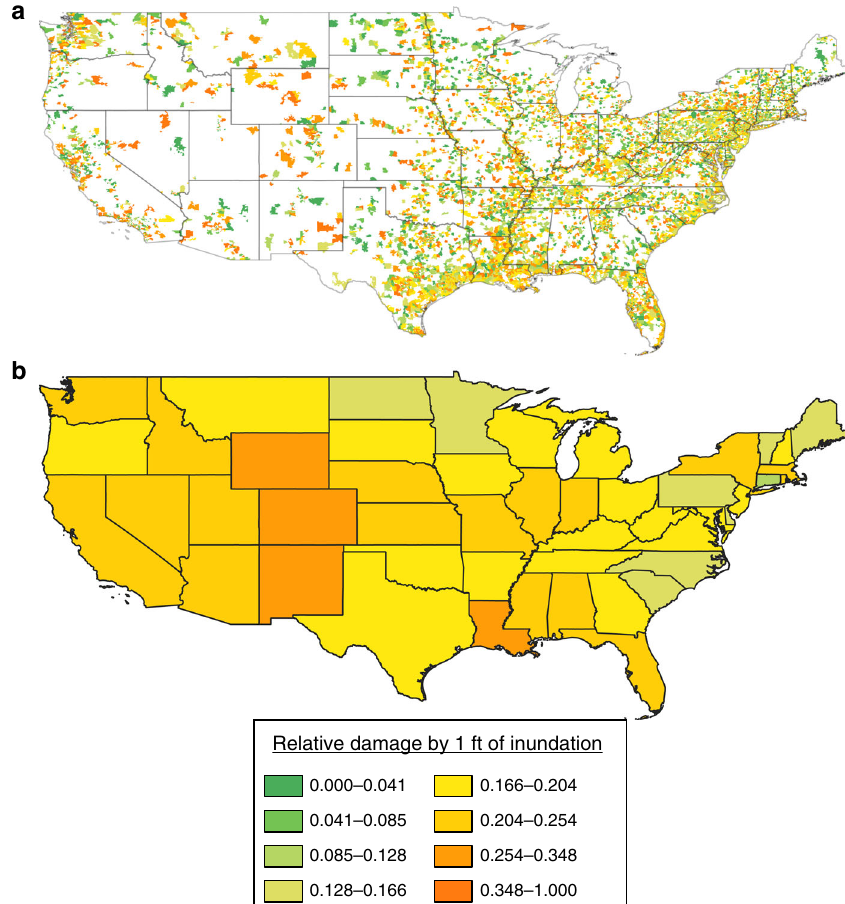
Fig. 3 The impact of 1 foot of inundation across the US. These maps show the spatial distribution of relative structural damages arising from NFIP claims where a one-story building without a basement was inundated by 1-foot of fl oodwater. Each spatial unit is representative of the mean damage within its area, summarized: a by zip code tabulation area and b by state. Blank areas in a indicate where no claims data exist to generate a depth – damage